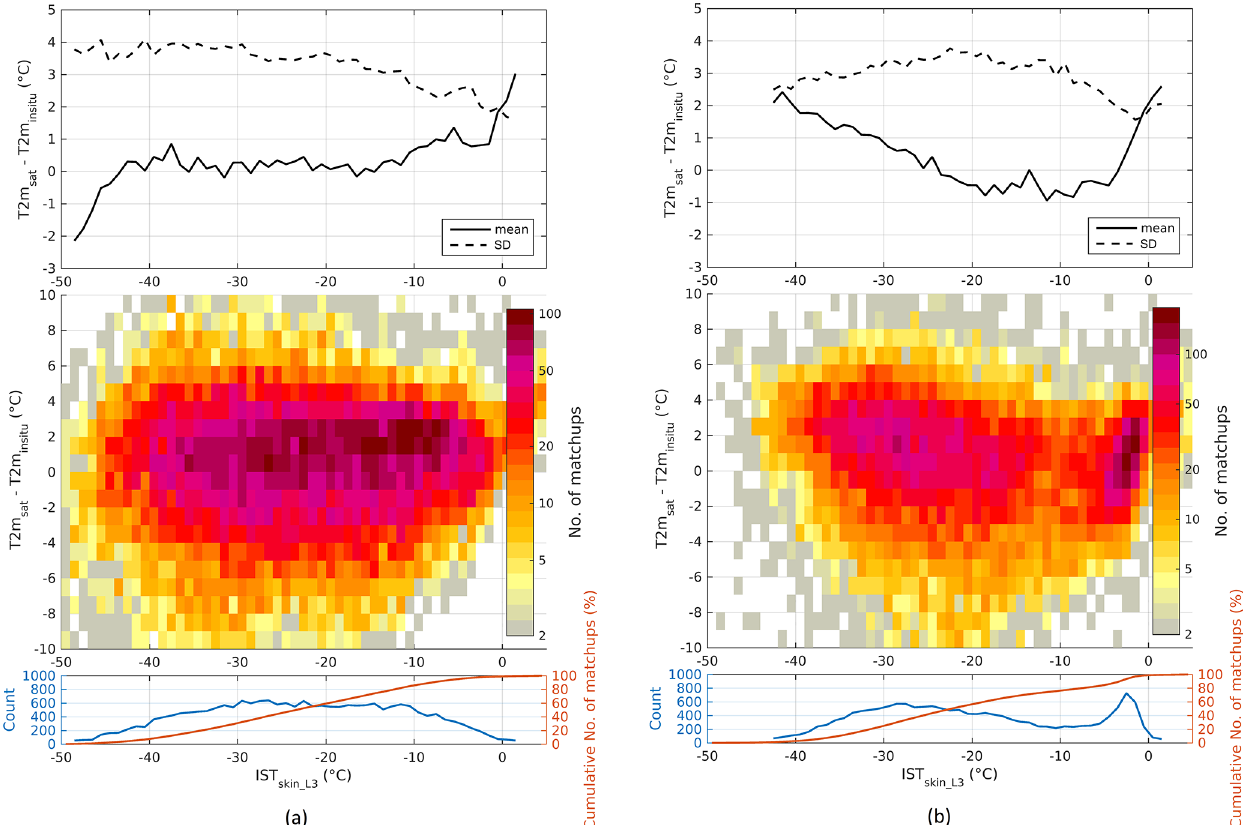
Figure 10. Estimated T2m minus observed T2m (bin size of 1 ◦ C) as a function of binned (bin size of 1 ◦ C) satellite IST skin_L3 for (a) land ice and (b) sea ice. The dashed lines are standard deviations while the solid lines are bias in the upper figure. The surface plots in the middle figures show the number of matchups in each bin while the bottom plots show the number of matchups (blue) and the cumulative percentage of matchups (red) in each IST skin_L3